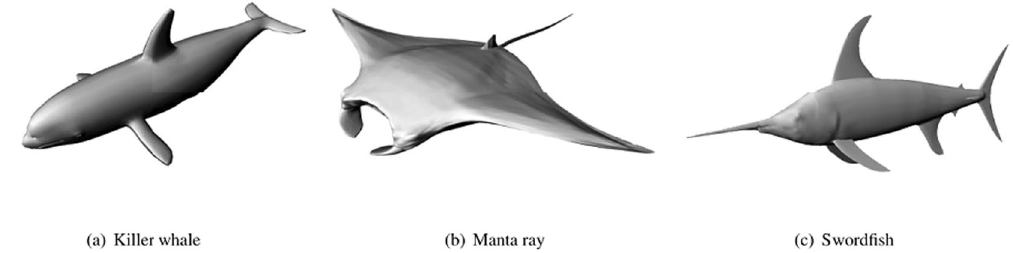
Figure 1. CAD models of the three marine animals, created in Rhinoceros 17